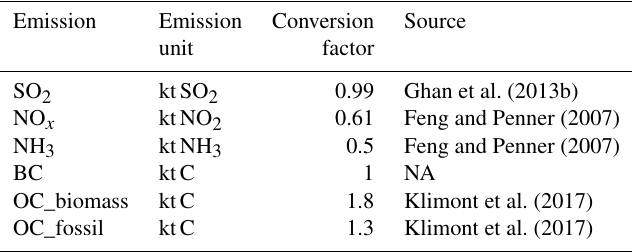
Table A1. Conversion factors used for the PM-equivalent emissions calculation. The factor converts emissions in terms of weight units used in the emissions inventory to the weight of particulate matter accounting for the fraction of emissions converted to aerosol and changes in molecular